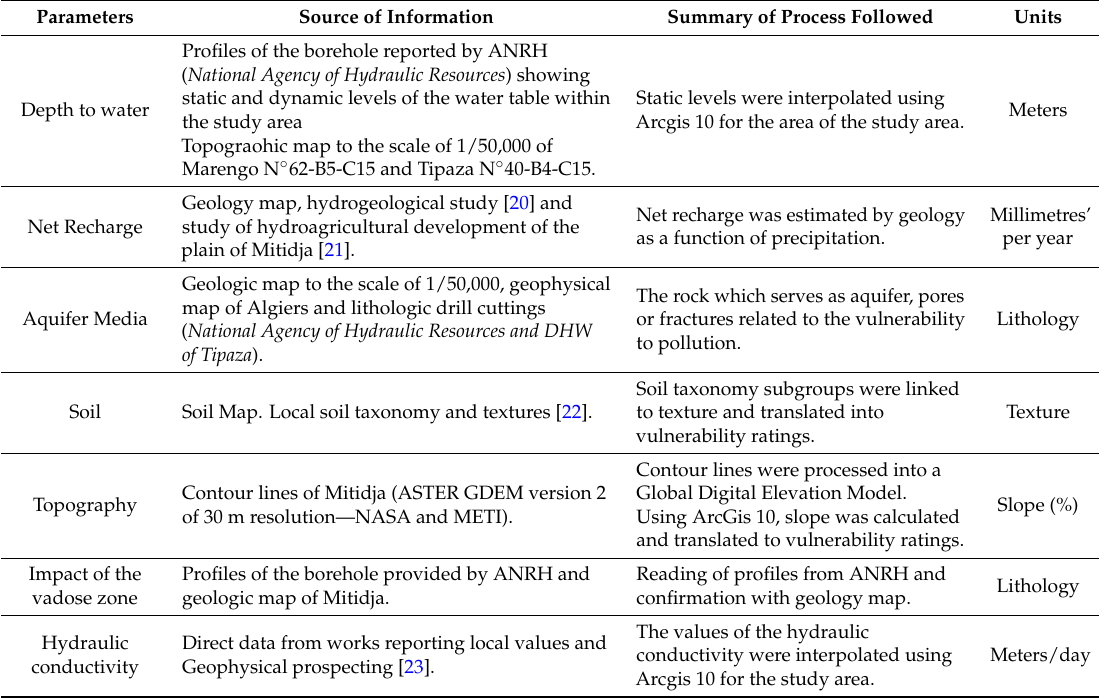
Table 1. Data and sources of information used in the present